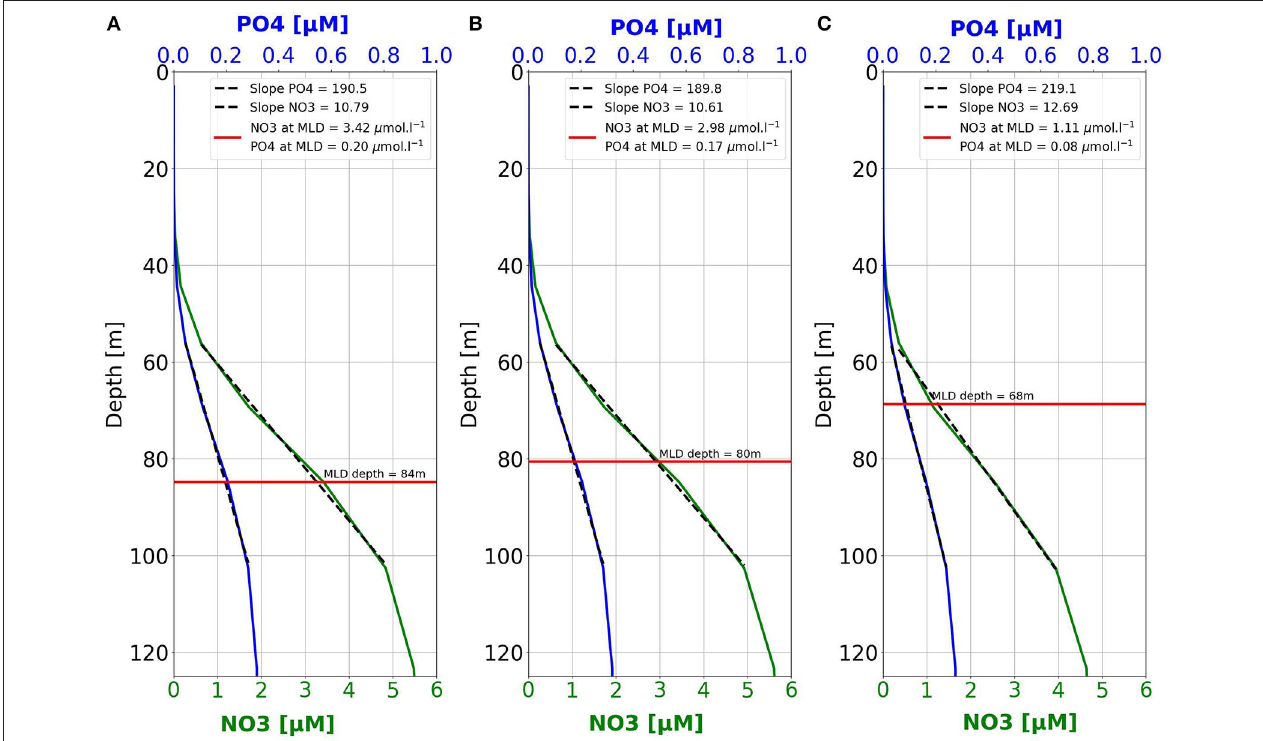
FIGURE 6 | Average profiles in autumn (September to November) of NO 3 (green) and PO 4 (blue) for the Western Basin for the periods: (A) 1986–2005; (B) 2021–2050; (C) 2071–2100. The red line shows the average mixed layers depth (MLD) in winter (January to March) for the same periods. Dotted lines show the linear relationship between nutrient concentrations and depth (green NO 3 and blue PO 4 ) between 60 and 100 m. These depths have been arbitrarily chosen in order to best represent the gradient regions of the nutriclines.